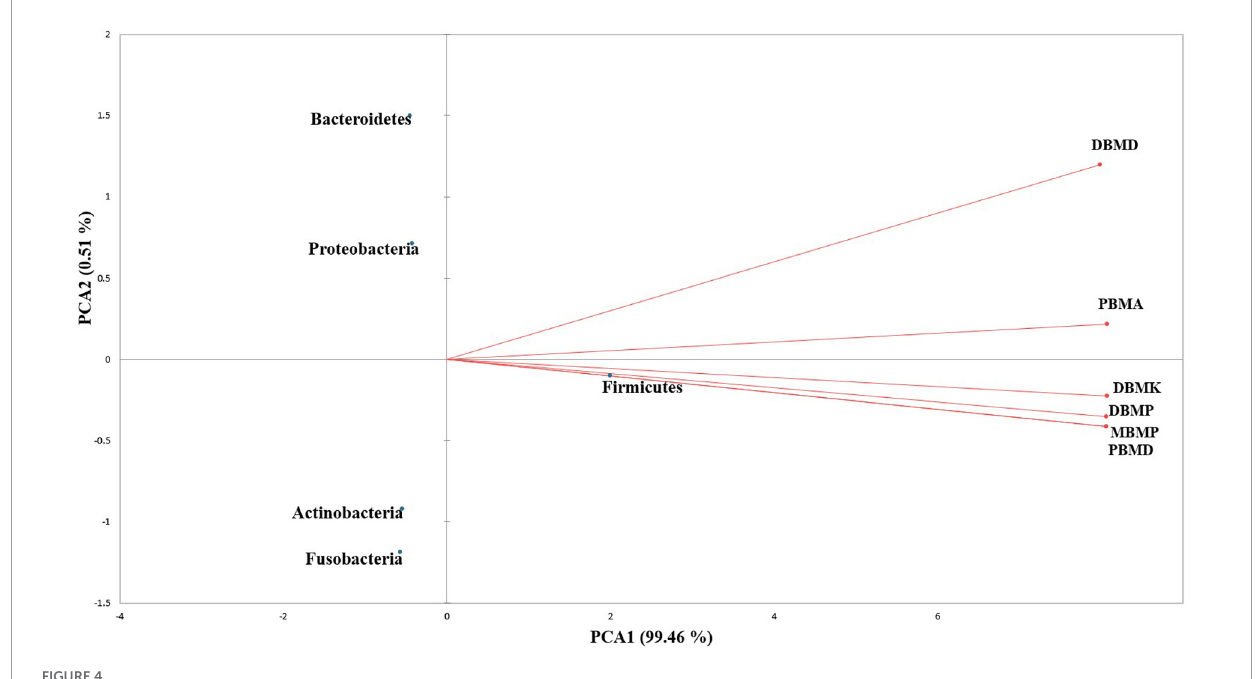
FIGURE4 PCA biplot analysis of samples and microbial diversity at the genus level.